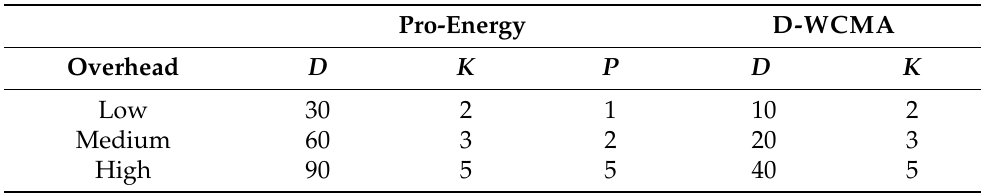
Table 1. Pro-Energy and Dynamic Weather Condition Moving Average (D-WCMA) settings. Pro-Energy